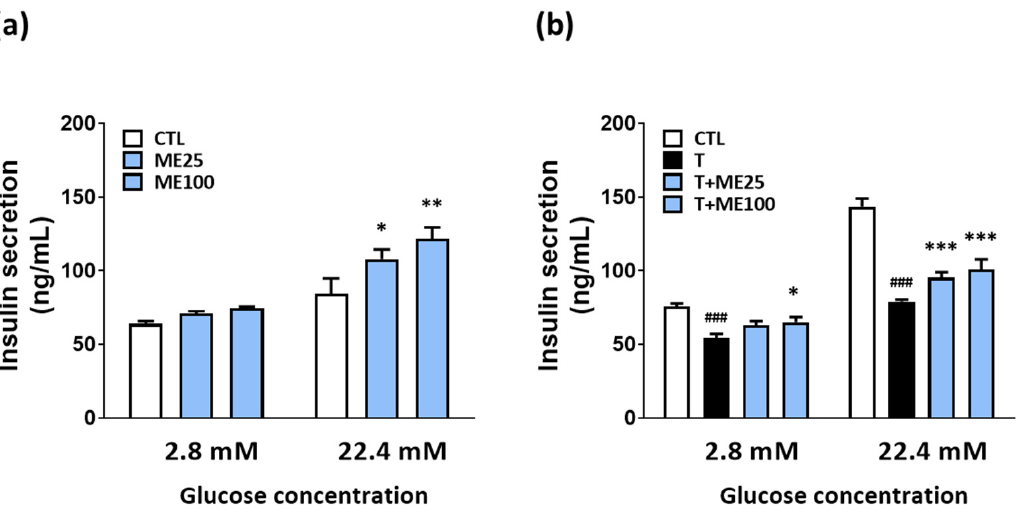
Figure 3. ME improved insulin secretion in NIT-1 pancreatic β -cells exposed to low or high glucose concentrations. ( a ) Treatment with ME alone in NIT-1 pancreatic β -cells. ( b ) Co-treatment of tunicamycin and ME in NIT-1 pancreatic β -cells. Results are represented as the mean ± SD of three separate experiments performed in triplicate. ### p < 0.001 versus CTL (vehicle-treated cells); * p < 0.05, ** p < 0.01, *** p < 0.001 versus tunicamycin-treated cells. T: tunicamycin; ME: Mori Ramulus ethanol extract.